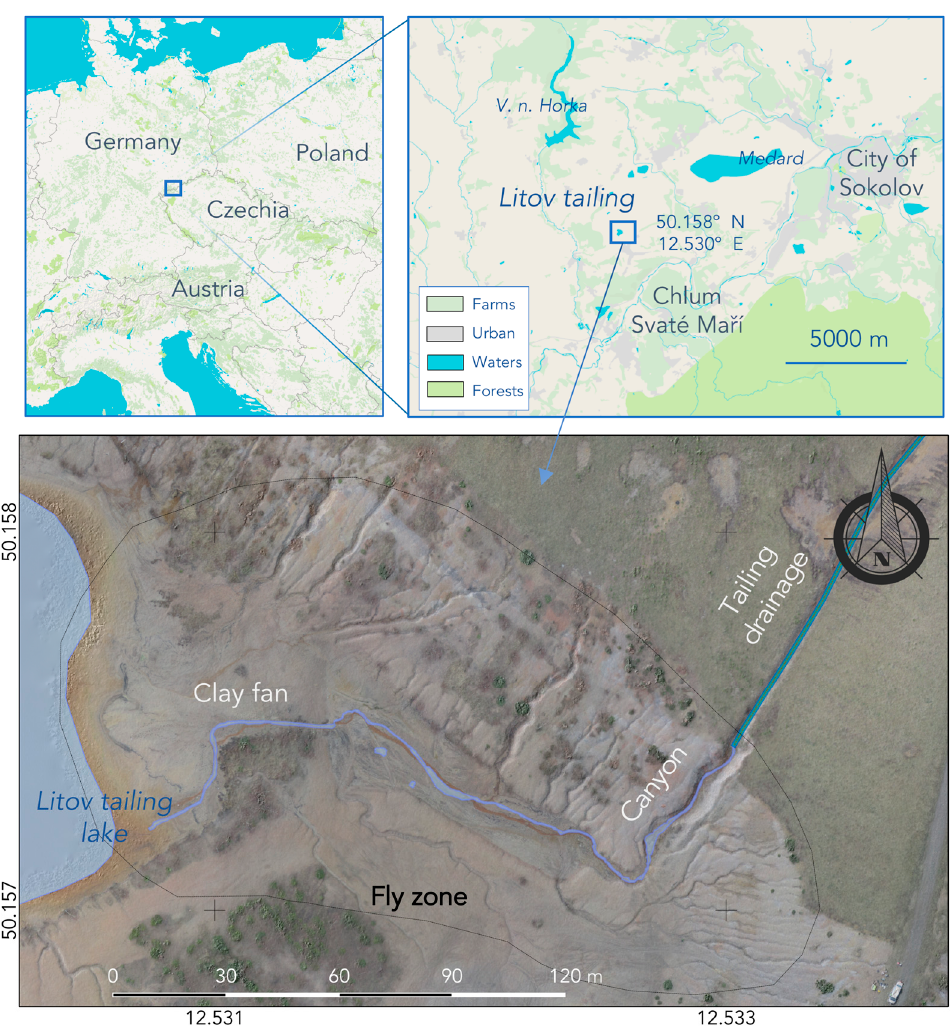
Figure 2. Location of test site in the district of Sokolov. The orthophoto was captured with the eBee UAV. Within the re-cultivated area is the actual tailing, east of the lake. Black arrows indicate dominant drainage directions. Collected orthophotos cover up to 0.635 km 2 , or 8.9%, of the waste heap. The region is part of the educational Czech-Bavarian Geopark.